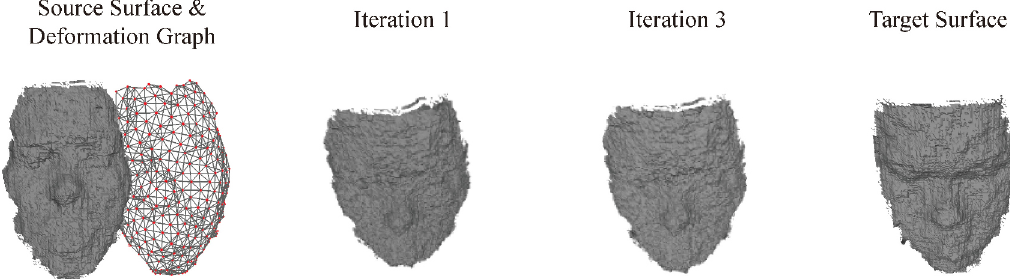
Fig. 2 Example of non-rigid registration. A deformation graph is embedded into the source surface. Two types of energy functions are used to fit the current correspondences between source and target surfaces, and constrain the deformation graph. Gauss–Newton iteration is used to solve above least-squares problem to obtain the optimal graph motion; interpolating it gives the optimal alignment surface.